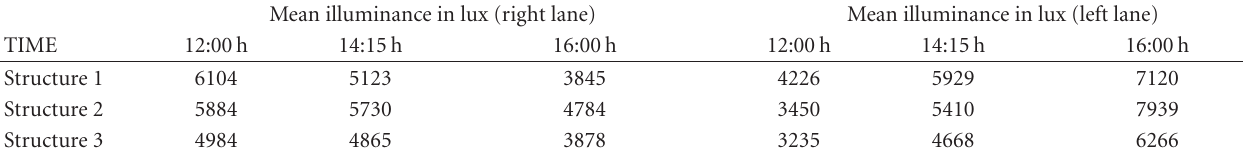
Table 2: Illuminance values under the three tension structures at di ff erent times of the day. Mean illuminance in lux (right lane) Mean illuminance in lux (left